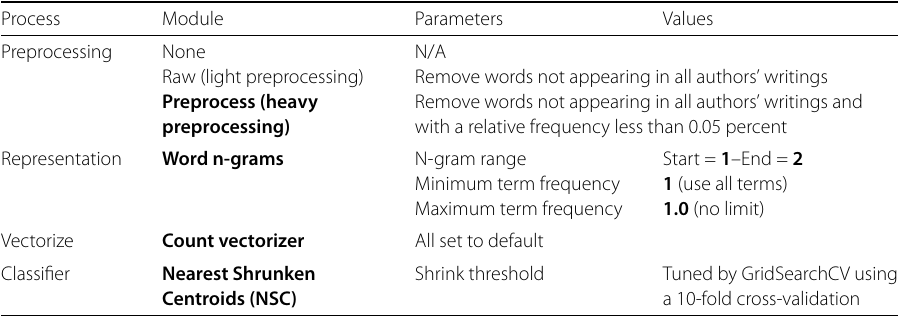
Table 7 Parametrization of NSC Model. Optimal settings are typeset in bold Process Module Parameters Values Preprocessing None N/A Raw (light preprocessing) Remove words not appearing in all authors’ writings Preprocess (heavy Remove words not appearing in all authors’ writings and preprocessing) with a relative frequency less than 0.05 percent Representation Word